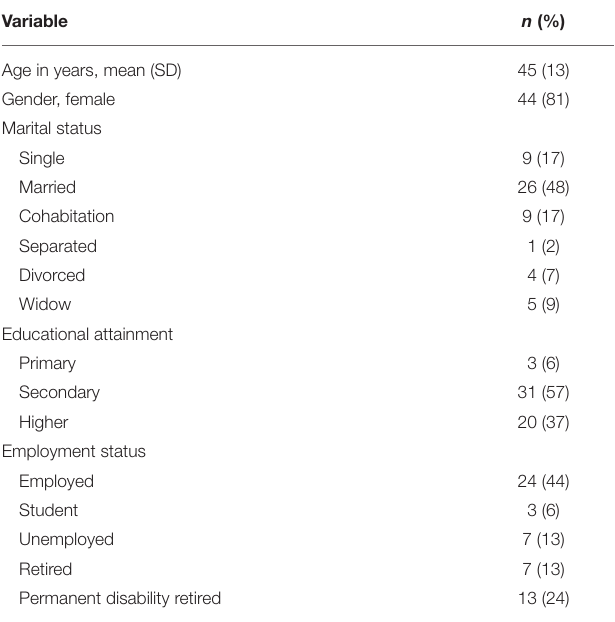
TABLE 1 | Socio-demographic profile of the